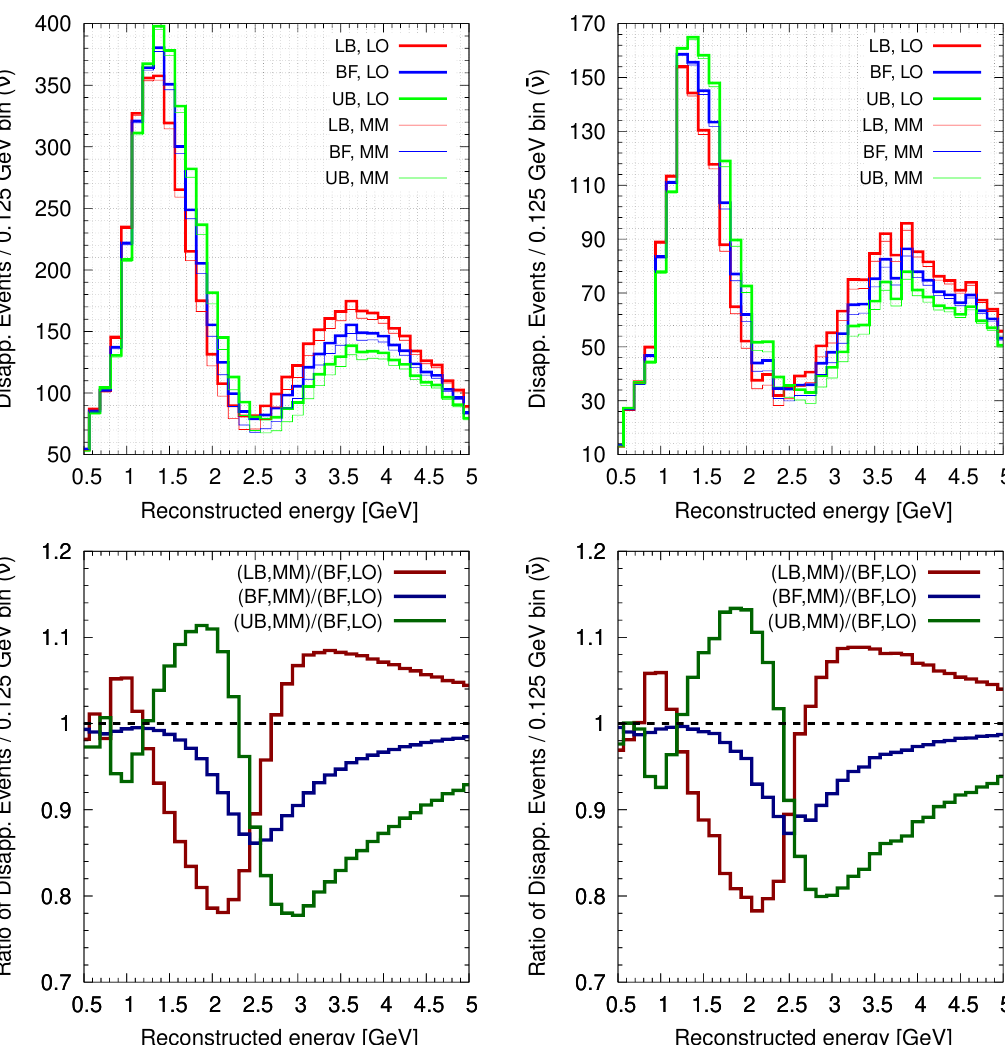
Figure 5 . In the top left (right) panel, we show the expected neutrino (antineutrino) disappearance event spectra as a function of reconstructed neutrino (antineutrino) energy assuming 3.5 years of ν ( ¯ ν ) run. The thick (thin) colored histograms correspond to a LO (MM) value of sin 2 θ = 23 0.455 (0.5). For a given value of sin 2 θ , we depict the event spectra for three different choices of 23 ∆ m 2 : 2.522 × 10 − 3 eV 2 [current best-fit (BF), blue lines], 2.436 × 10 − 3 eV 2 [current 3 σ lower bound 31 (LB), red lines], and 2.605 × 10 − 3 eV 2 [current 3 σ upper bound (UB), green lines]. In the bottom left panel, we show the ratio of neutrino disappearance events in each energy bin as a function of reconstructed neutrino energy assuming 3.5 years of ν run. We present the same for antineutrino in the bottom right panel. The brown, blue, and green curves show the ratio of N , N , and N , 1 /N 2 /N 3 /N respectively, where N : events in a given energy bin for (cid:0) ∆ m 2 = 2 . 522 × 10 − 3 eV 2 , sin 2 θ = 0 . 455 (cid:1) , 23 31 (cid:0) ∆ = 2 . 436 × 10 − 3 eV 2 , sin 2 θ = 0 . 5 (cid:1) , N : events in a N 1 : events in a given energy bin for m 2 23 2 31 given energy bin for (cid:0) ∆ m 2 = 2 . 522 × 10 − 3 eV 2 , sin 2 θ = 0 . 5 (cid:1) , and N : events in a given energy 23 3 31 bin for (cid:0) ∆ m 2 = 2 . 605 × 10 − 3 eV 2 , sin 2 θ = 0 . 5 (cid:1) 23 31